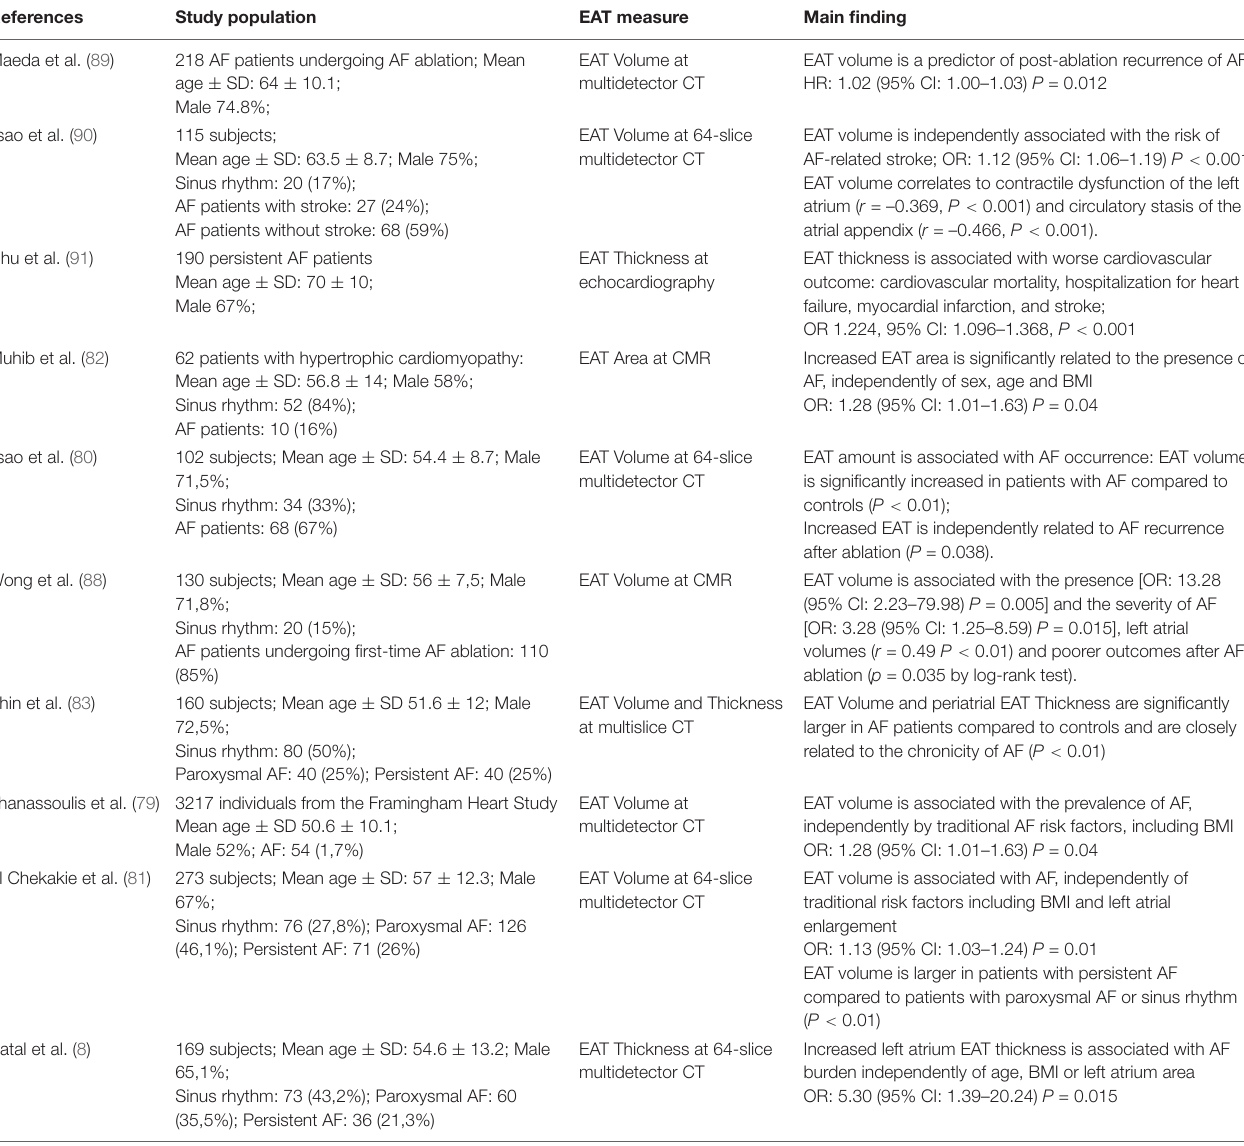
TABLE 1 | Associations between EAT and AF occurrence, severity and